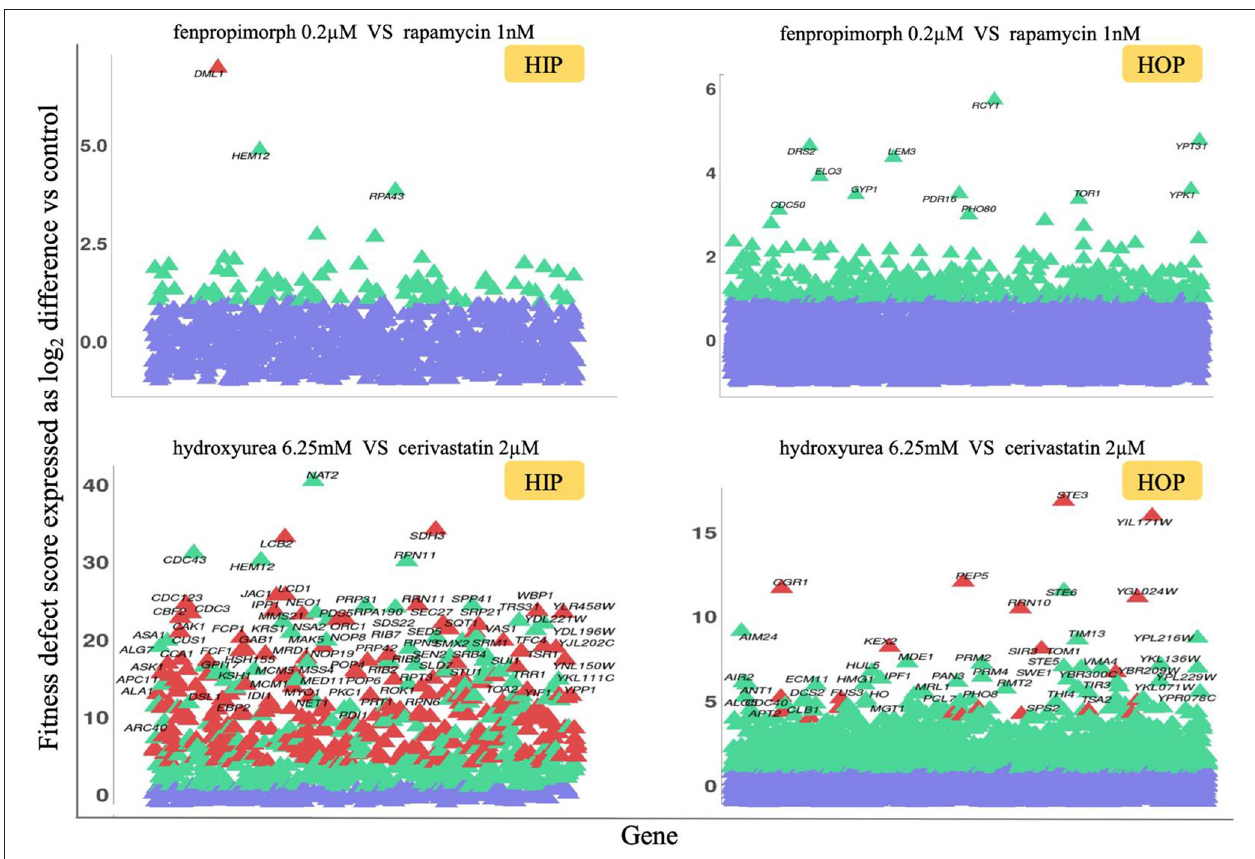
FIGURE 4 | HIP–HOP screening of select drug combinations. For each combination screen, a drug combination that inhibited wild-type yeast growth by 20% was selected and screened alongside each single agent. To identify combination-specific strains, we required that the fitness defect in the combination be 2.0 or greater and that in each single agent, the fitness defect for that strain did not exceed 2.0. For clarity, the heterozygous essential (HIP scatterplots) and homozygous non-essential (HOP scatterplots) data are plotted separately. Significantly sensitive strains are highlighted in green, and combination-specific strains are depicted in red, while violet shows non-significantly sensitive strains. The fitness defect scores are shown on the y-axes. In the case of the fenpropimorph vs. rapamycin combination (top plots), only a single strain, the essential gene DML1 , was identified as a combination-specific strain. This gene product has been implicated in diverse aspects of mitochondrial function. For the hydroxyurea vs. cerivastatin combination (bottom plots), a larger number of combination-specific strains are apparent. Among these are essential genes involved in sphingolipid biosynthesis ( LCB2 ), mitochondrial metabolism ( SDH3 , JAC1 ) as well as cell cycle checkpoints, and protein degradation at the metaphase anaphase transition ( LCD1 , CDC23 , and CBF2 ). Non-essential strains specific to this combination include those involved in response to diverse stresses ( STE3 , CGR1 ) and targeted protein degradation ( PEP5 , KEX2 ).